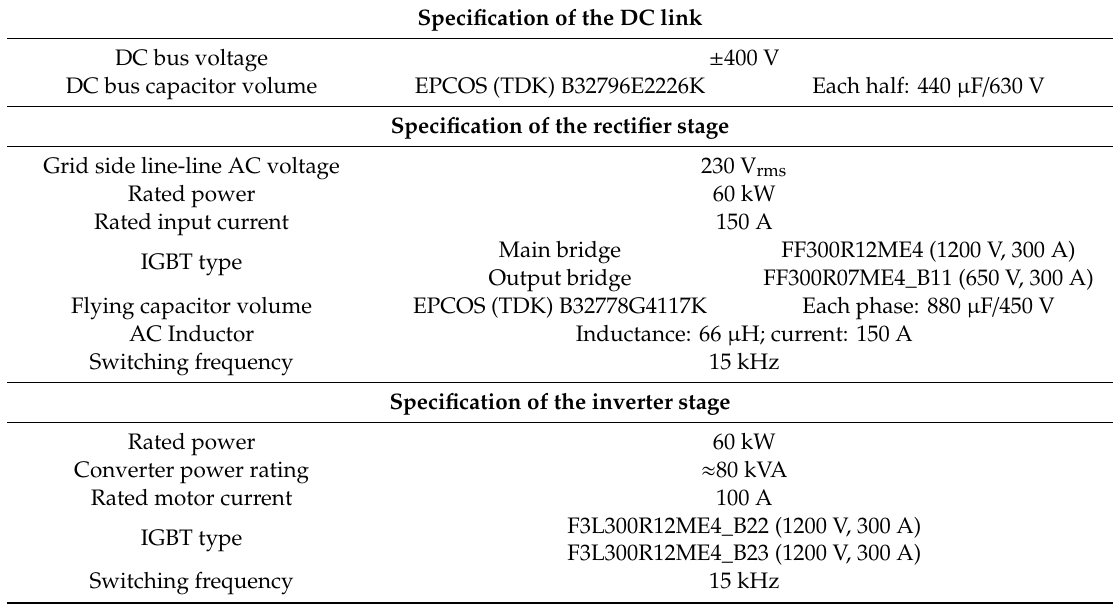
Figure 6. Schematic of a 5L-HANPC and 3L-NPC converter prototype. Table 4. Specifications and components selection results of the 5L-HANPC and 3L-NPC